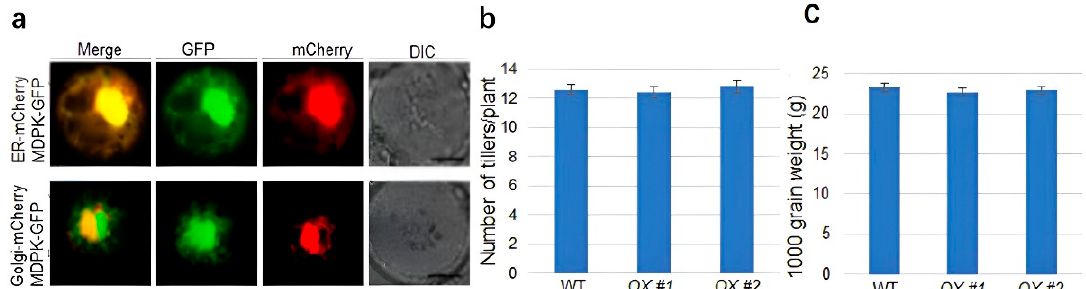
Figure 5. The function and subcellular localization of MDPK : ( a ) subcellular localization of MDPK- GFP fusion protein in rice protoplasts. Bars = 10 µ m; ( b ) number of effective tillers and ( c ) 1000-grain weight per plant were calculated from wild-type and OX #1 and OX #2 plants. Data indicate average ± standard error (SE) ( n > 10).